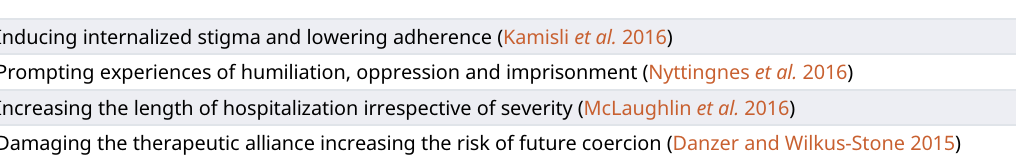
Table 6. Evidence on the negative impact of compulsive treatment. Inducing internalized stigma and lowering adherence (Kamisli et al. 2016)